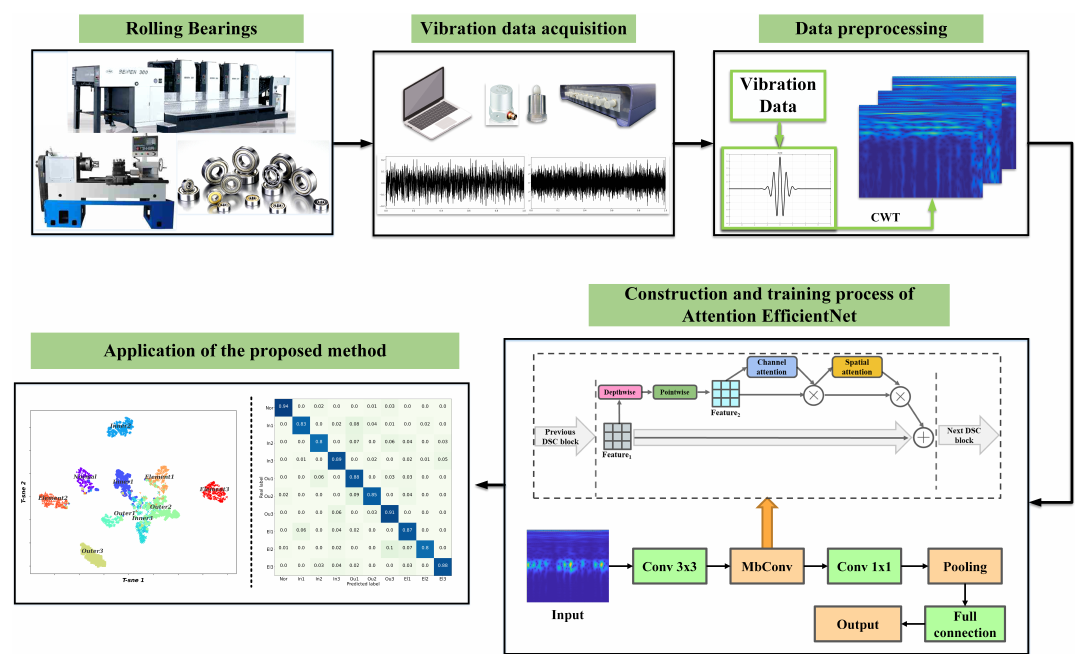
Figure 3. General diagnosis procedure of attention